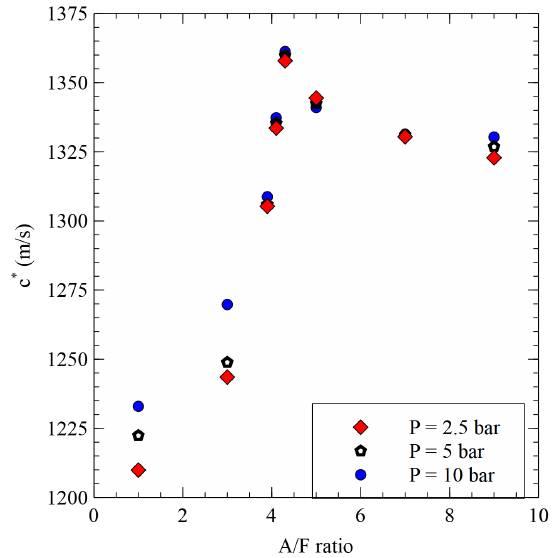
Figure 6. c ∗ data obtained from CEA